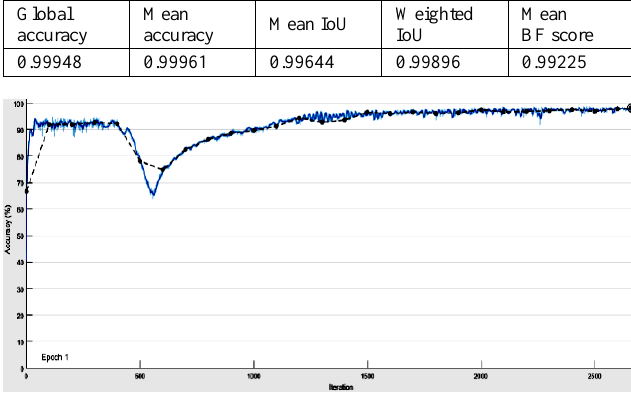
Fig. 8. The accuracy of the SSN (Fig. 5) without the DropOut layer trained during the first epoch, after which the validation accuracy achieves 98.11 %.